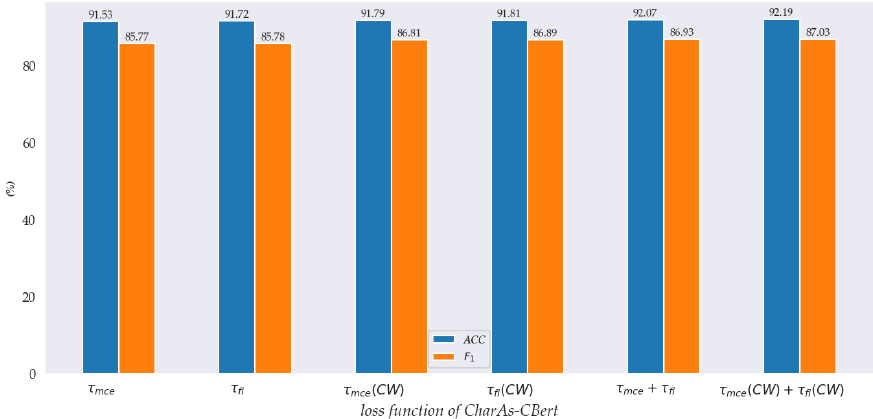
Figure 3. The performance of different loss functions on the Laptop datasets. CW indicates class weights; τ mce indicates multiclass cross entropy loss; τ fl indicates focal loss; τ mce ( CW ) indicates multiclass cross entropy loss with class weights.